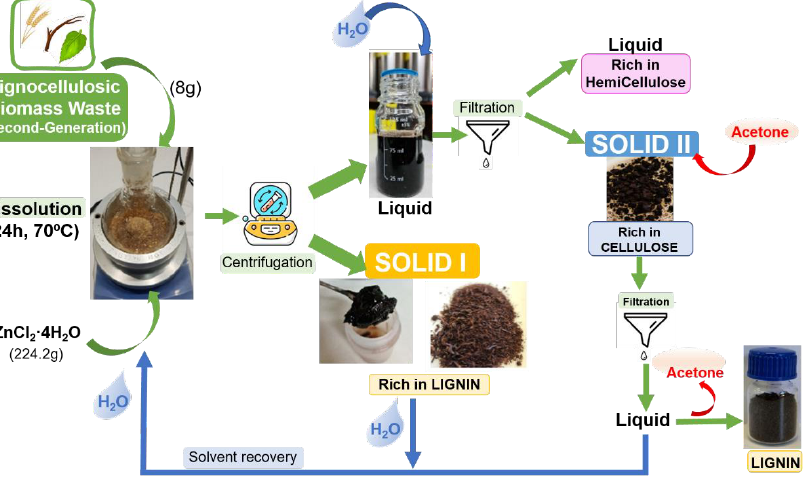
Figure 1. Scheme of the process of the fragmentation of lignocellulosic biomass using ZnCl 2 ·4H 2 O. Hydrolysis. Hydrolysis reactions were carried out in a thermostatic Teflon-lined steel stirred reactor equipped with a stirred magnet and a pressure addition funnel (BR- 100, Berghof Intruments) [14,16,38]. A total of 0.5 g of material was added to the reactor with 40 mL of water and heated to 140 °C. Subsequently, 10 mL of H 2 SO 4 (0.2 M) was added and from this moment, the “ reaction time ” was